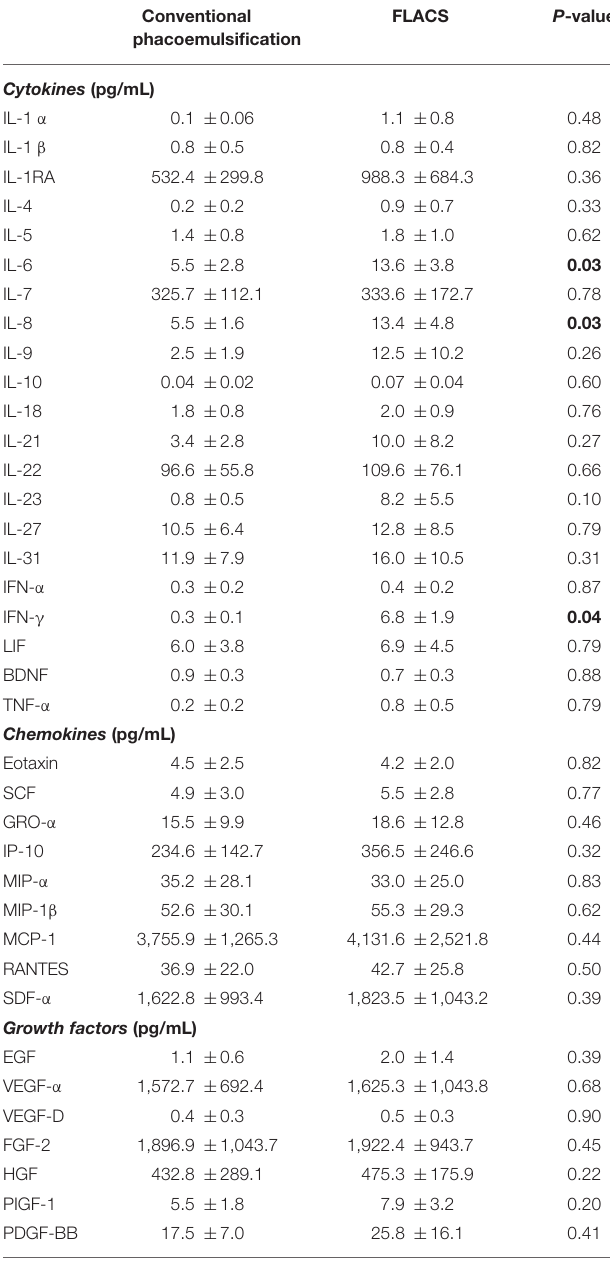
TABLE 3 | Aqueous humor concentrations of cytokines, chemokines and growth